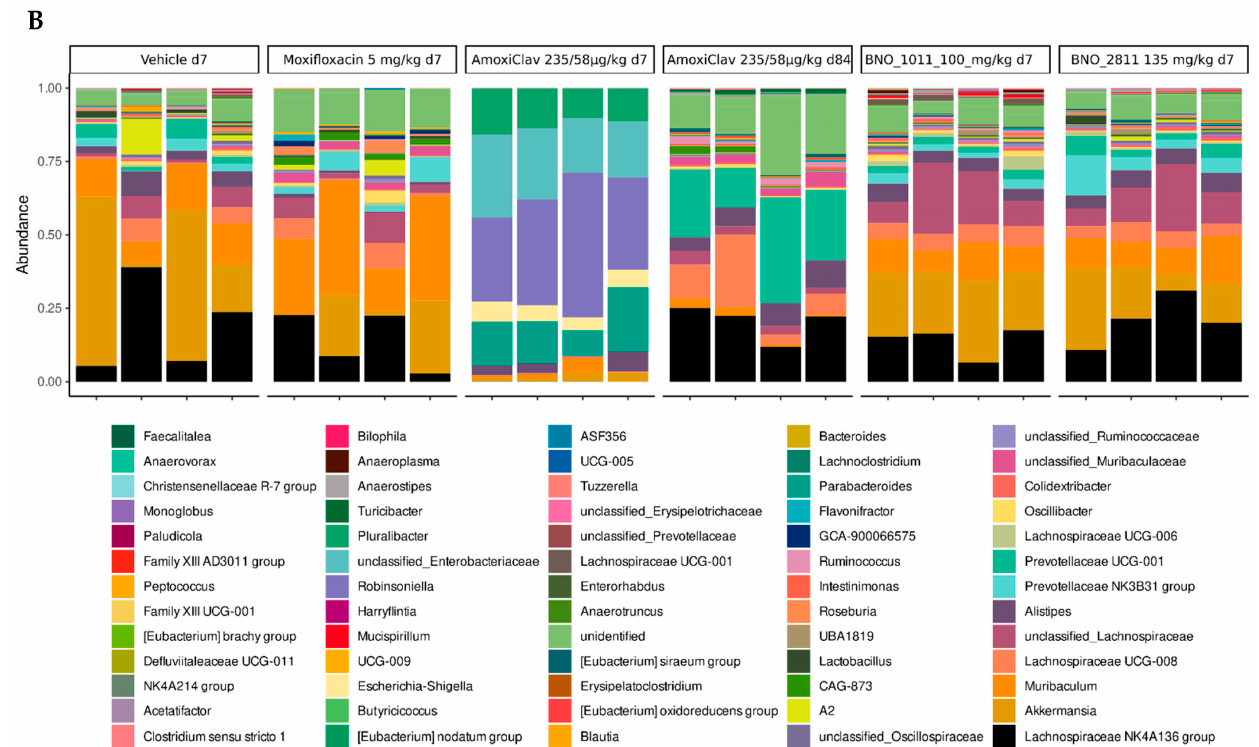
Figure 1. Changes in microbiome after treatment of mice with amoxicillin/clavulanic acid (day 7 and 84), moxifloxacin (day 7), BNO 2811 (day 7), or BNO 1011 (day 7), compared to a control group (water). ( A ) Similarity between individual bacterial compositions were studied using principal coordinates analysis (PCoA) of 16S rRNA gene sequencing data. Individual samples (colored dots) clustered well, according to the treatment groups. Ellipses represent the 95% confidence intervals, based on a multivariate t-distribution for each group. The center of each group is marked by small dots. Differential clustering of treatment groups after PCoA indicates compositional shifts after seven days of antibiotic treatment with amoxicillin/clavulanic acid (orange dots). Additional shifts of bacterial compositions 11 weeks after discontinuation of amoxicillin/clavulanic acid (d84, red triangles) point to a long-term damage of the microbiome, due to the antibiotic treatment. Bacterial compositions of mice treated with BNO 1011 and BNO 2811 showed high similarity to untreated mice, inferring no impact on the intestinal microbiome. Coordinates represent 41.4 and 16.1 percent variance of the dataset. ( B ) Taxonomy bar plot illustrating relative abundances of detected bacterial genera in samples and treatment groups.